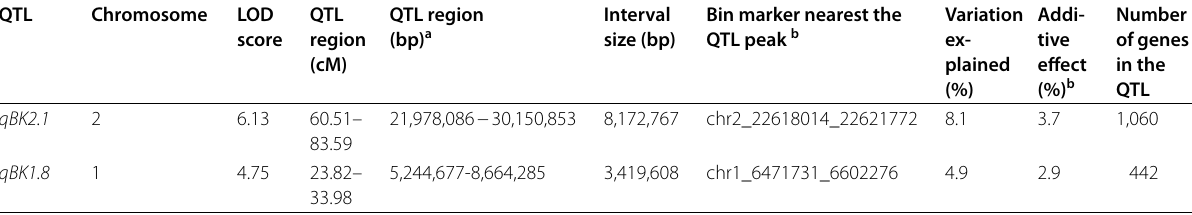
Table 2 Significant QTLs identified from 166 recombinant inbred lines (RILs) of ‘TK16’ × ‘Budda’